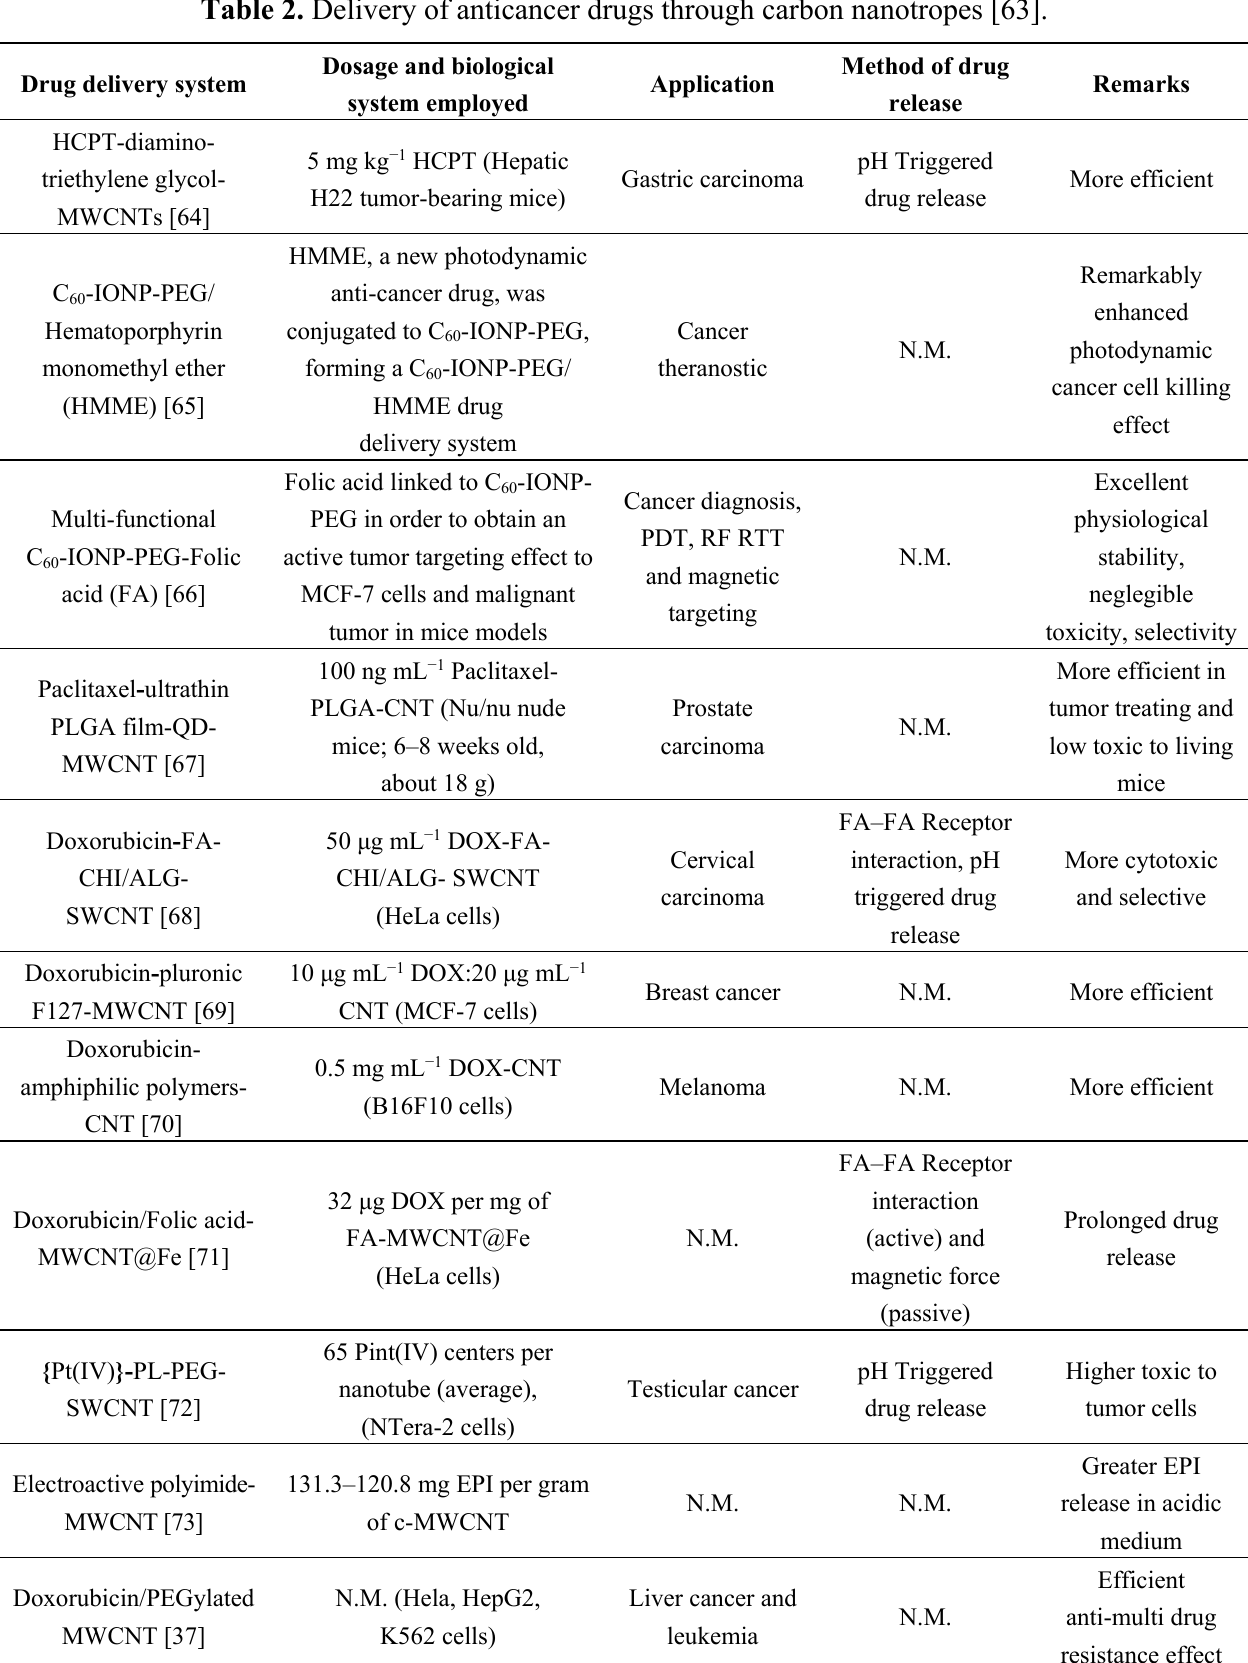
Table 2. Delivery of anticancer drugs through carbon nanotropes